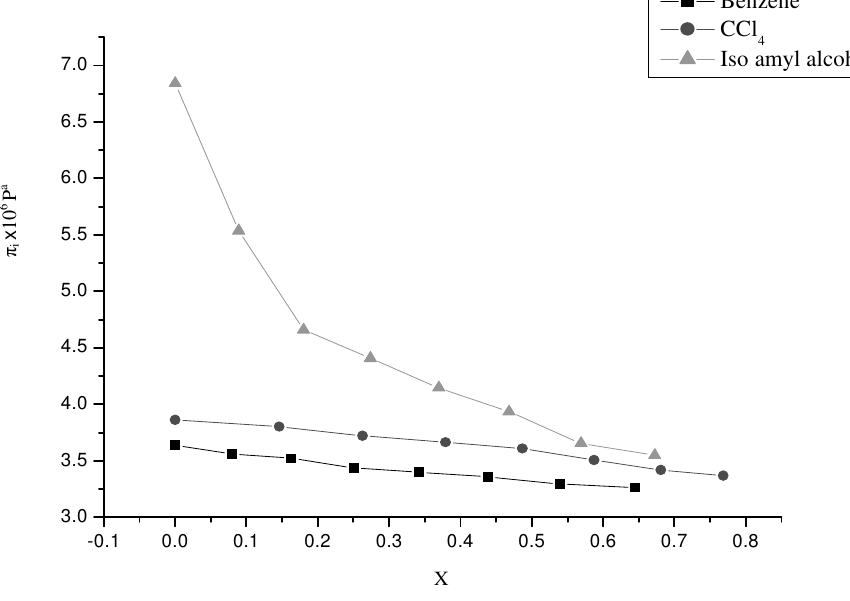
), with mole fraction for all the systems i